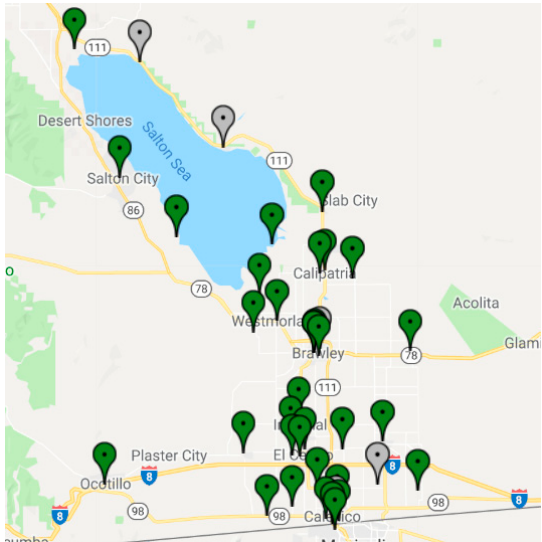
Figure 1. Map of IVAN low-cost sensors in the Imperial Valley for a particular day [28]. Green pins are monitors operating on the day, grey pins are monitors that were offline.